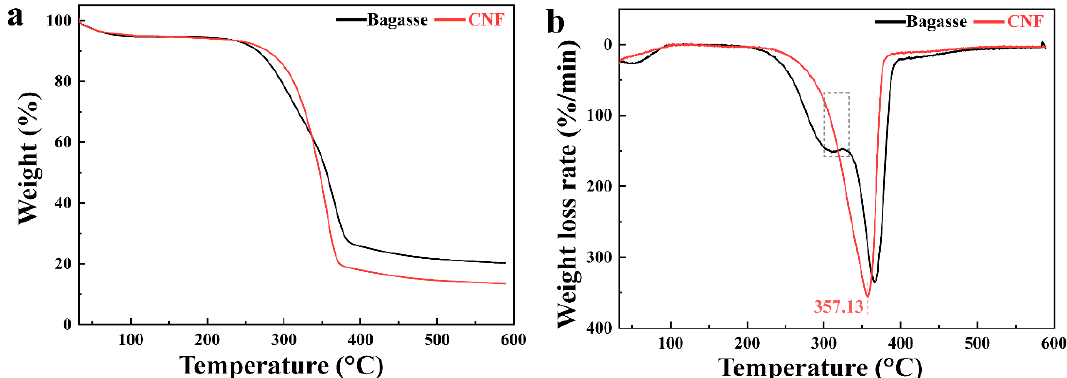
Figure 8. Thermogravimetric analysis (TGA) and DTG curves of the bagasse and CNFs: ( a ) TGA and ( b )